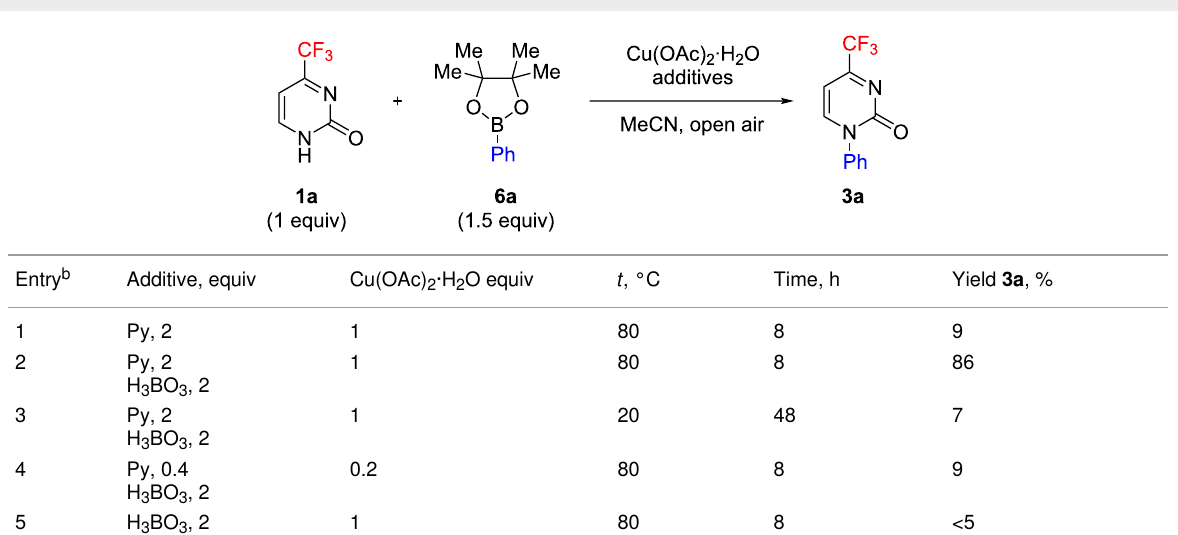
Table 2: Effect of boric acid and pyridine additives on the Chan–Evans–Lam reaction of 4-trifluoromethylpyrimidin-2(1 H )-one ( 1 а ) with phenylboronic acid pinacol ester ( 6 а ).